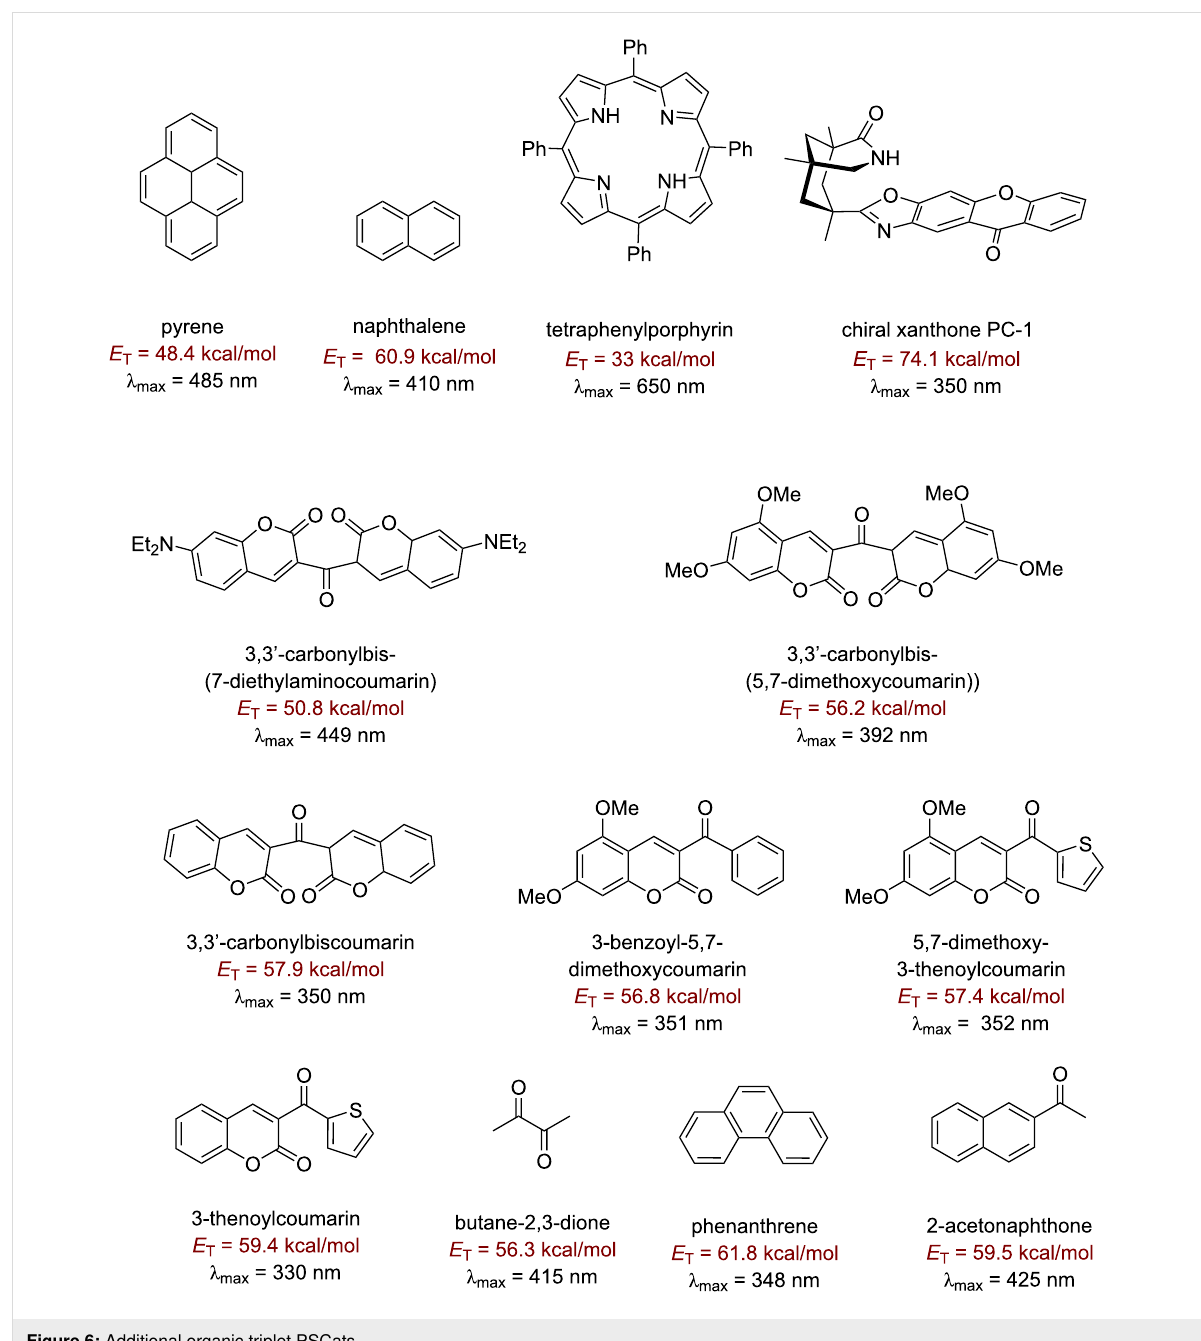
Figure 6: Additional organic triplet